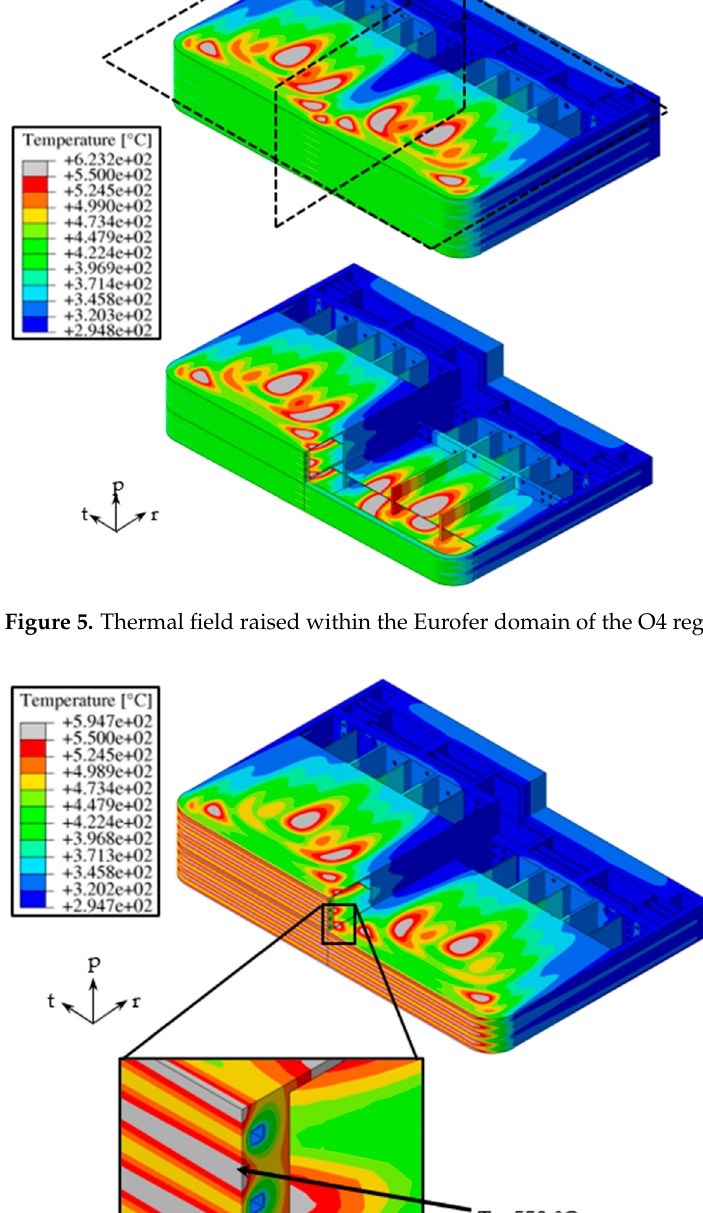
Table 3. Maximum temperature per region equipped with v06b layout.